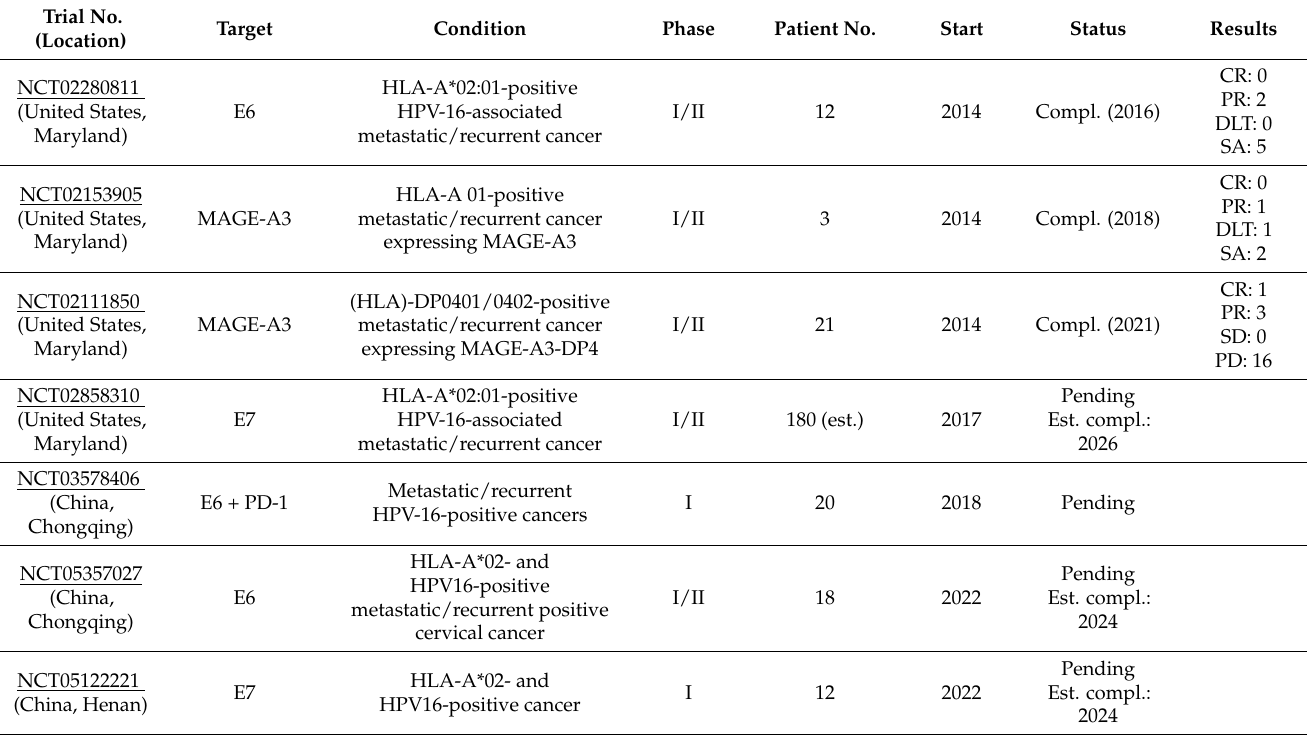
Table 2. TCR-T cell-based clinical trials against cervical